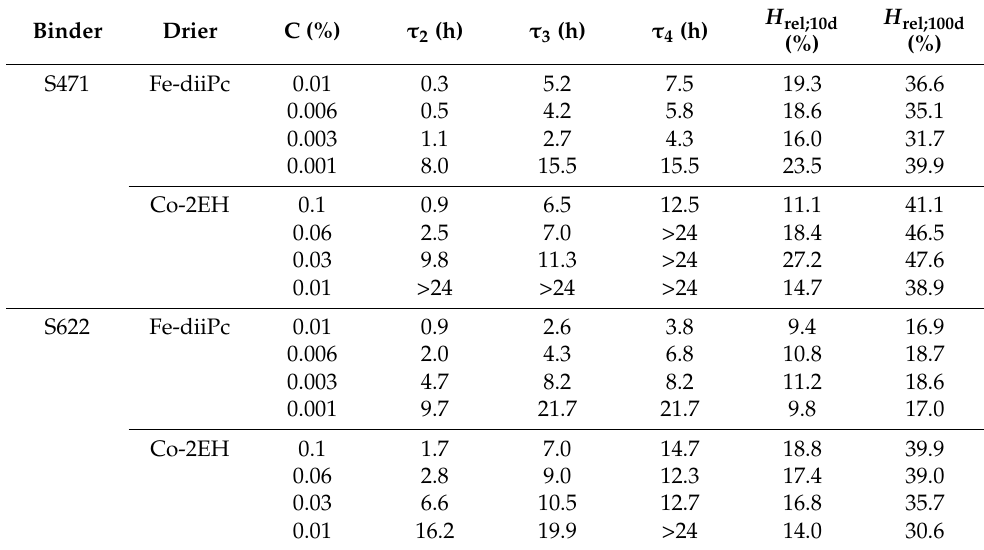
Table 1. Drying times 1 and relative hardness 2 of solvent-borne alkyd formulations. Binder